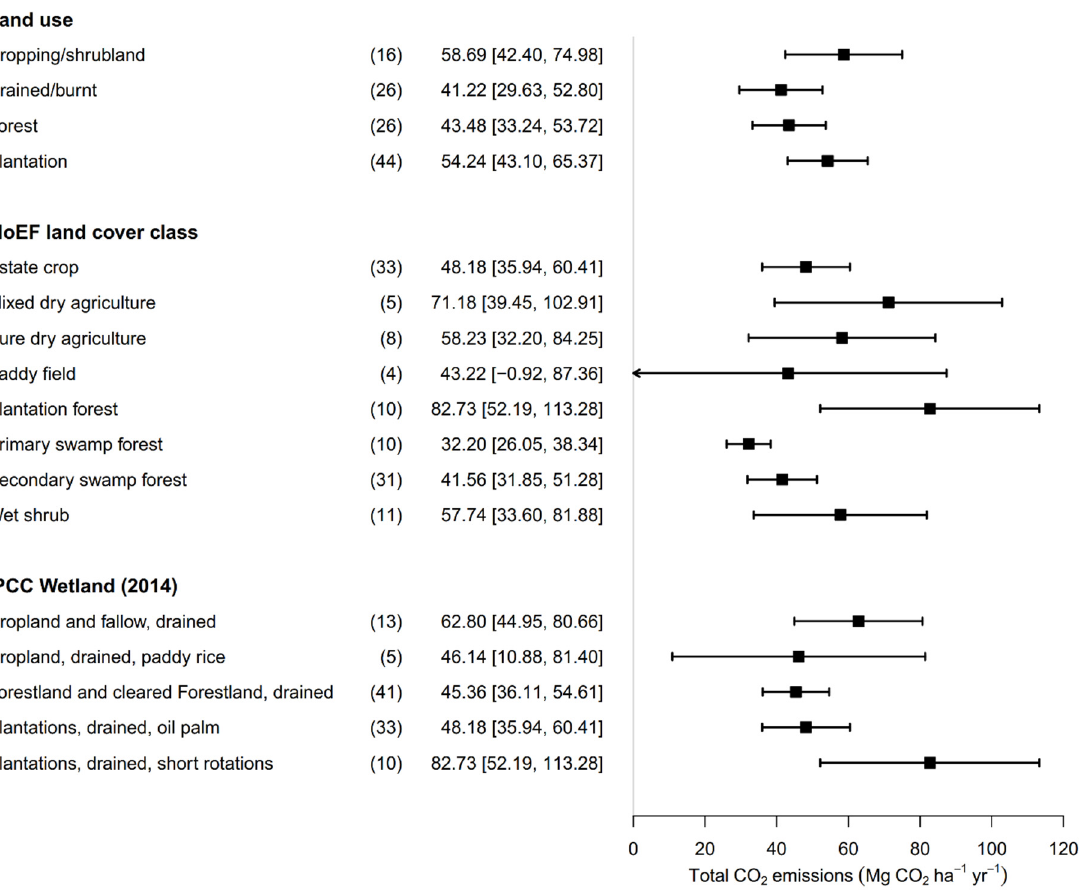
Figure 2. Total CO 2 emissions factors of Indonesia’ peatlands for each land use and land cover class. The number of observations is provided in parentheses, followed by the mean and lower and upper bounds of the confidence interval in square brackets, separated by a comma.